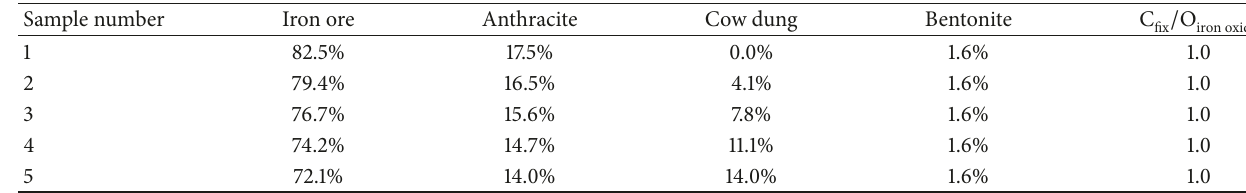
Table 3: Raw material ratio of the carbon-bearing iron ore